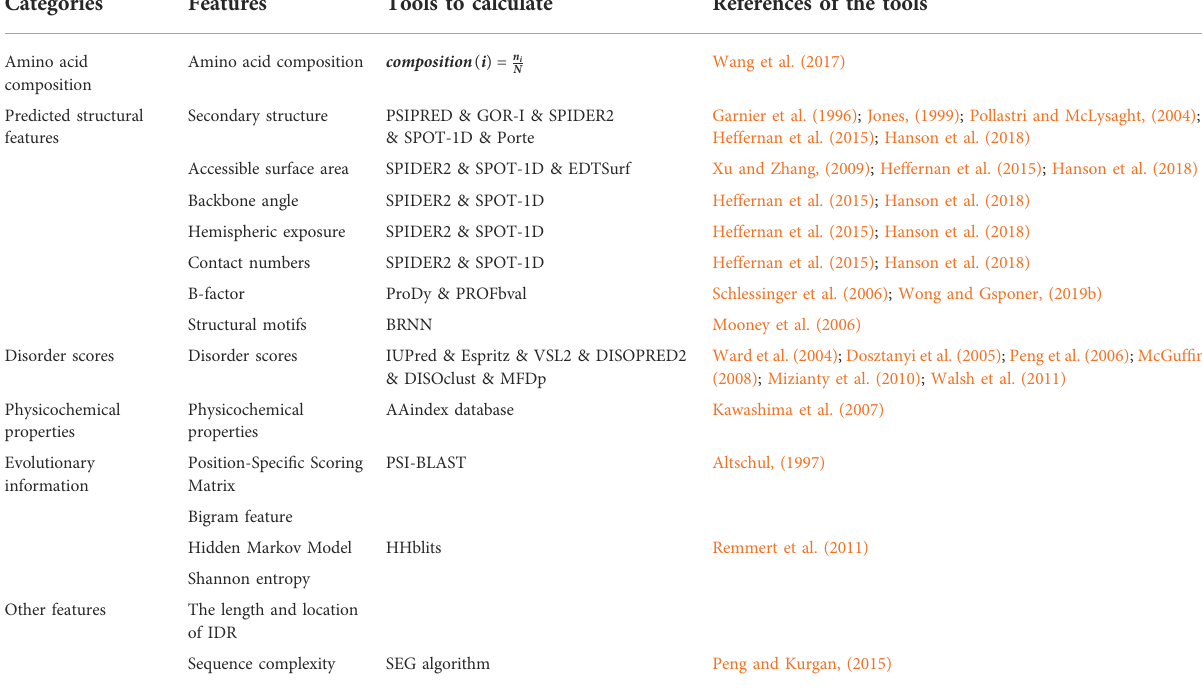
TABLE 1 Common features of intrinsically disordered protein-protein interaction sites